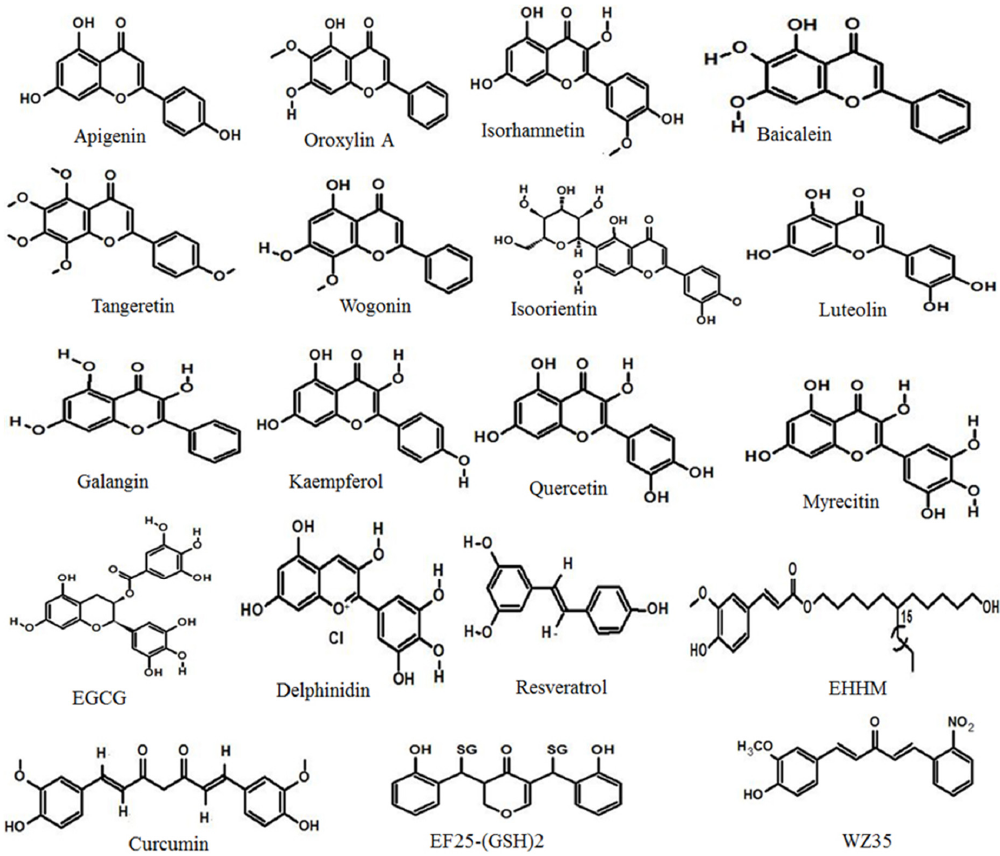
Figure 2. The chemical structures of autophagy-inducing anti-HCC polyphenols.